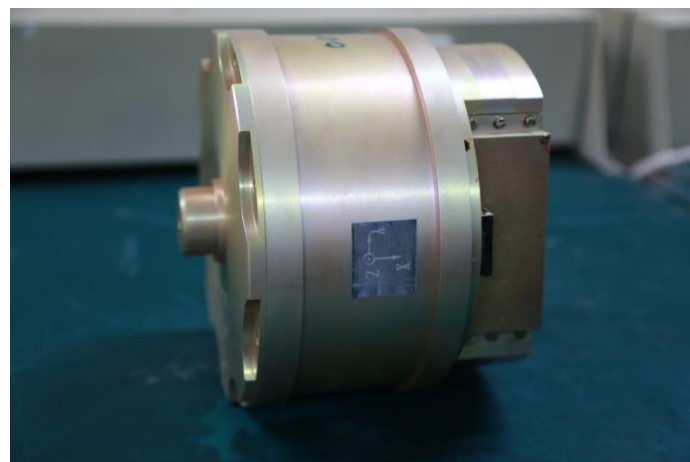
Figure 9. The reference trajectory for simulation.